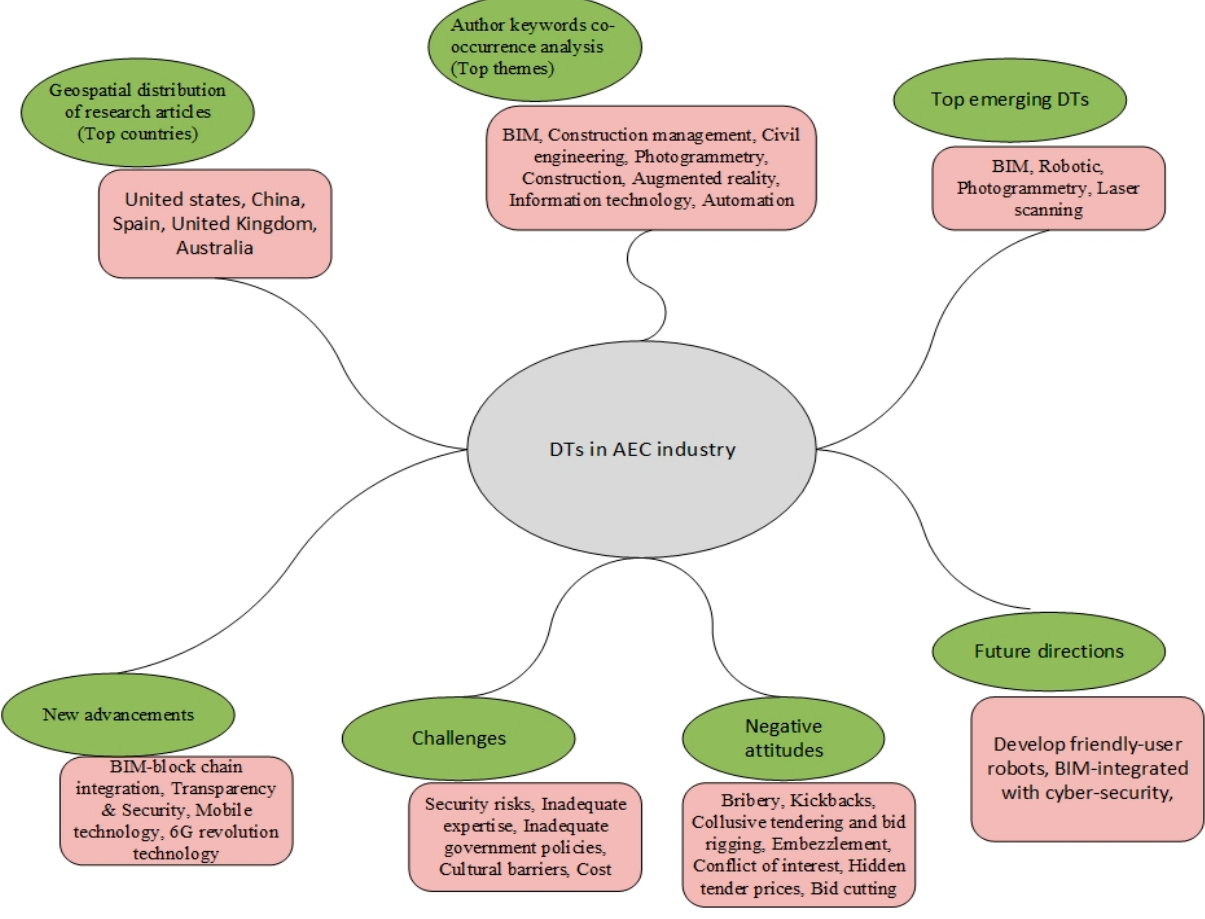
Figure 7. Summary of findings .